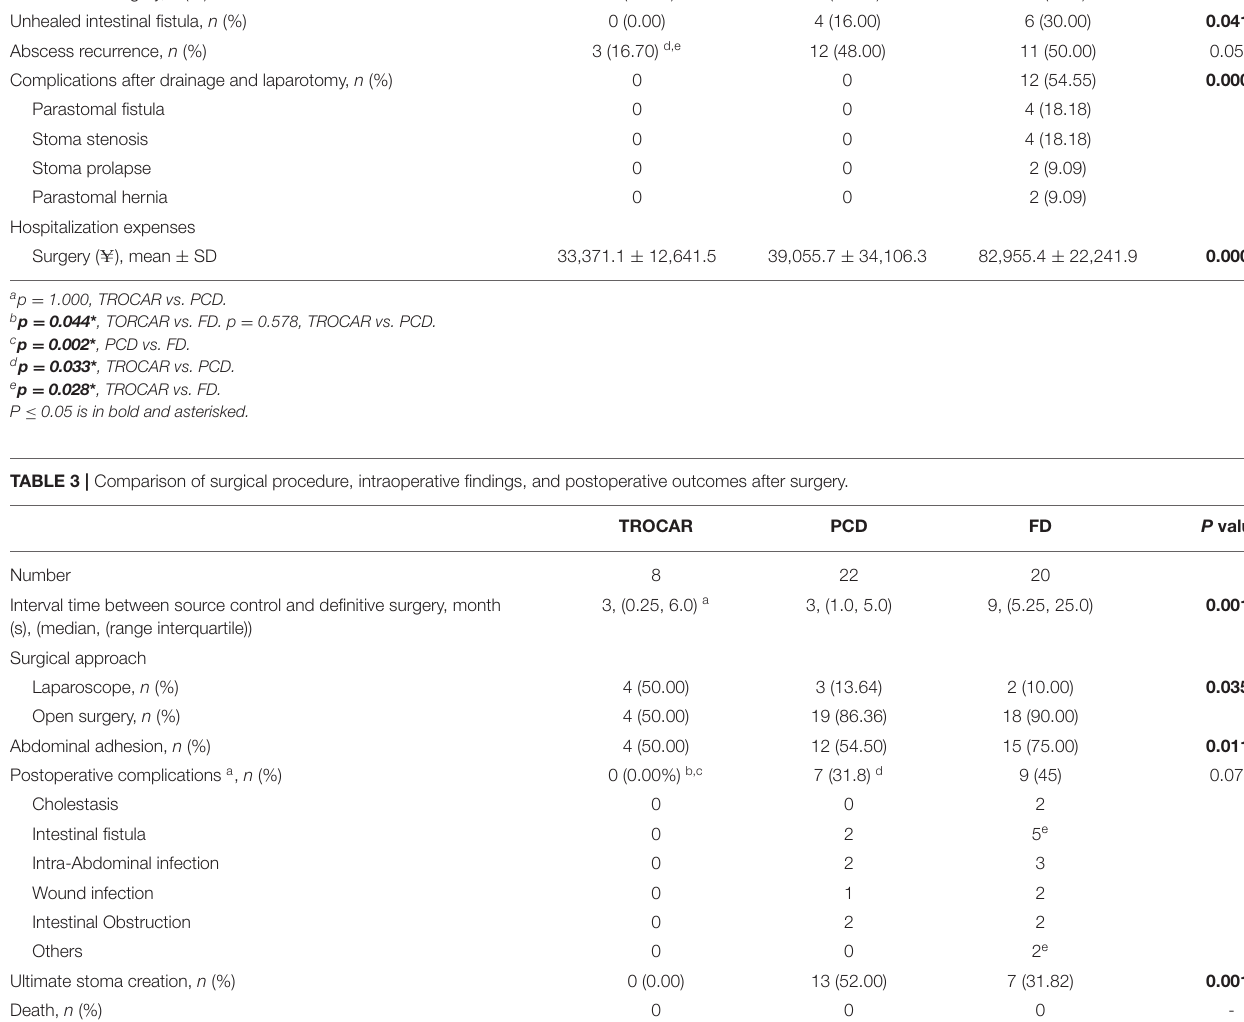
TABLE 2 | Outcomes of the initial management of abscess. Follow-up time, month (s) (mean ± SD)